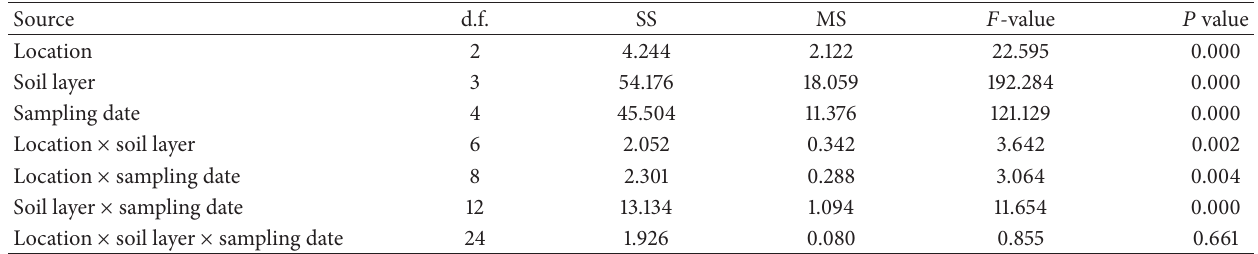
Table 1: Three-way ANOVA of the effects of location, soil layer, sampling date, and their interactions on the soil moisture content.